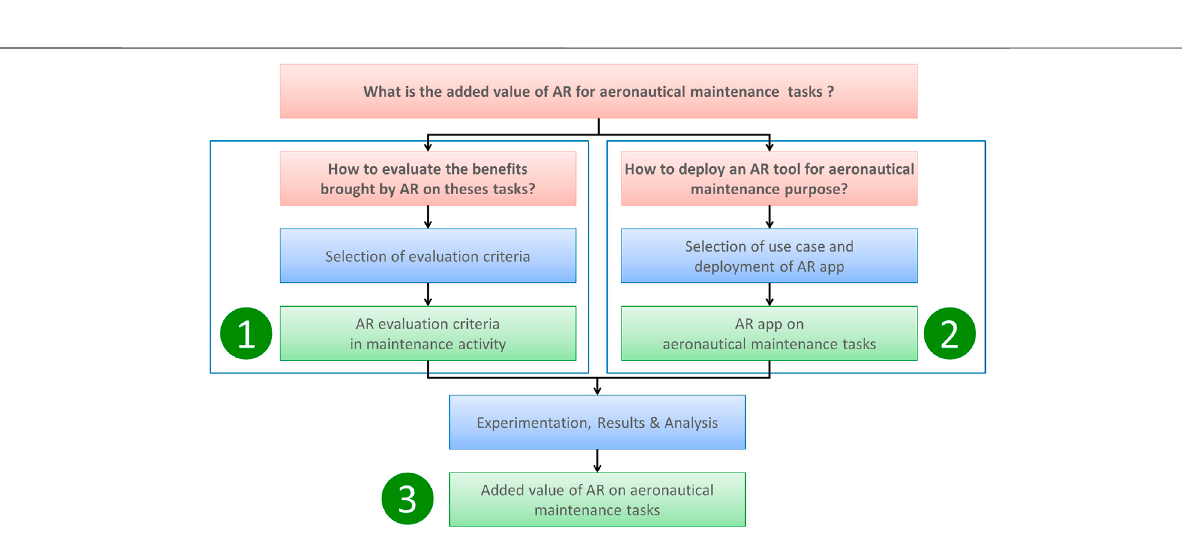
Frontiers in Virtual Reality |